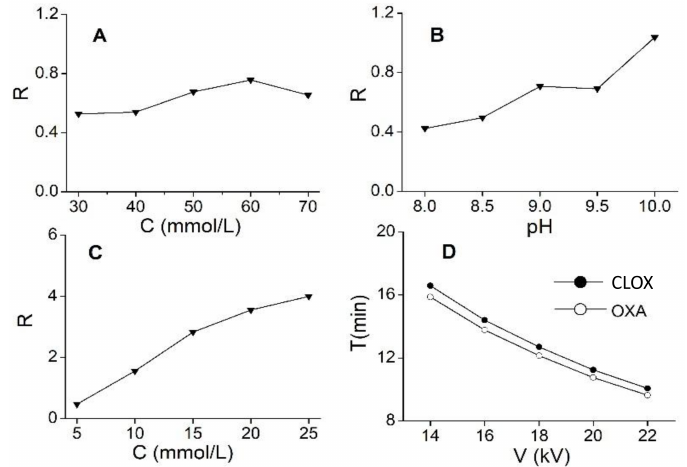
Figure 5. Effect of parameters of capillary electrophoresis with a diode array detector (CE-DAD) on the separation of analytes. Conditions: ( A ) the concentration of borax in the buffer; ( B ) the pH of the buffer; ( C ) the concentration of sodium dodecyl sulfate (SDS) in the buffer; ( D ) the separation voltage. R, the resolution between oxacillin (OXA) and cloxacillin (CLOX); T, the migration time of analytes. The concentration of analytes: 5.0 μ g/mL.